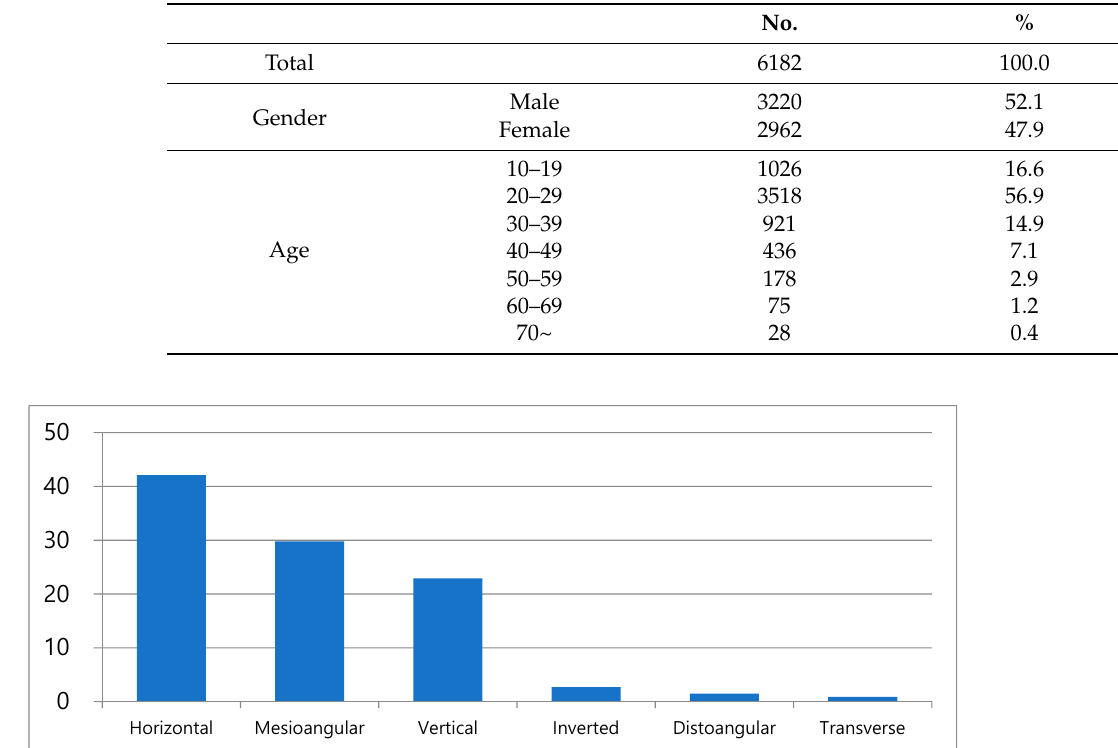
Table 1. Distributions of gender and age.